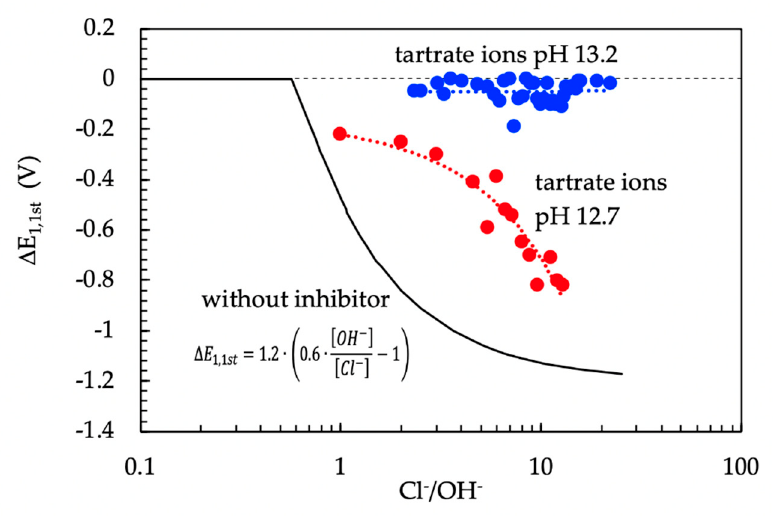
Figure 11. ∆ E 1,1st as a function of Cl − / OH − ratio in simulating pore solutions at pH 12.6–13.87 without inhibitors [59] and in Ca(OH) 2 sutured at pH 12.7 and Ca(OH) 2 sat. + NaOH at pH 13.2 solutions, added with 1 M of tartrate ions .